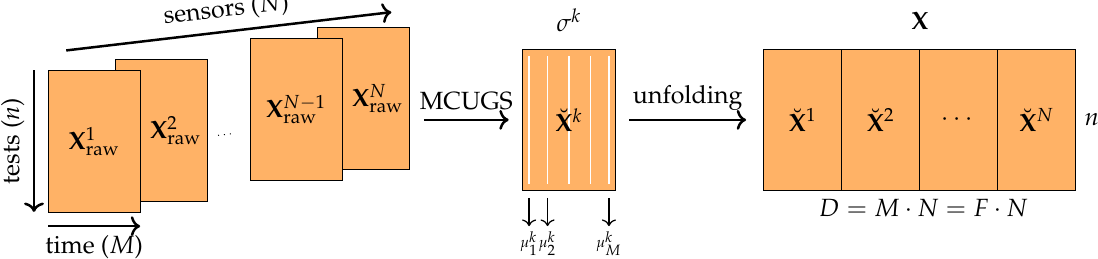
Figure 5. Initial data arrangement, MCUGS and unfolding dataset #2 and dataset #3, where F = M